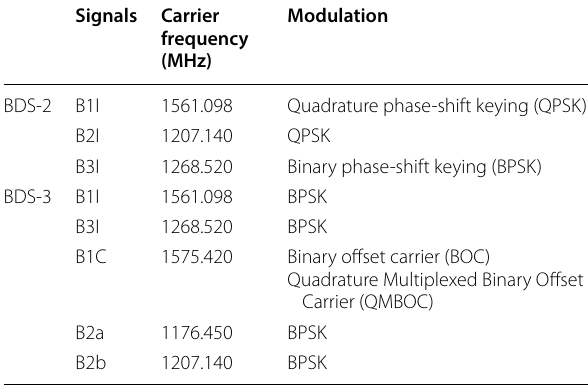
Table 1 Information of the BDS-2 and BDS-3 signals Signals Carrier